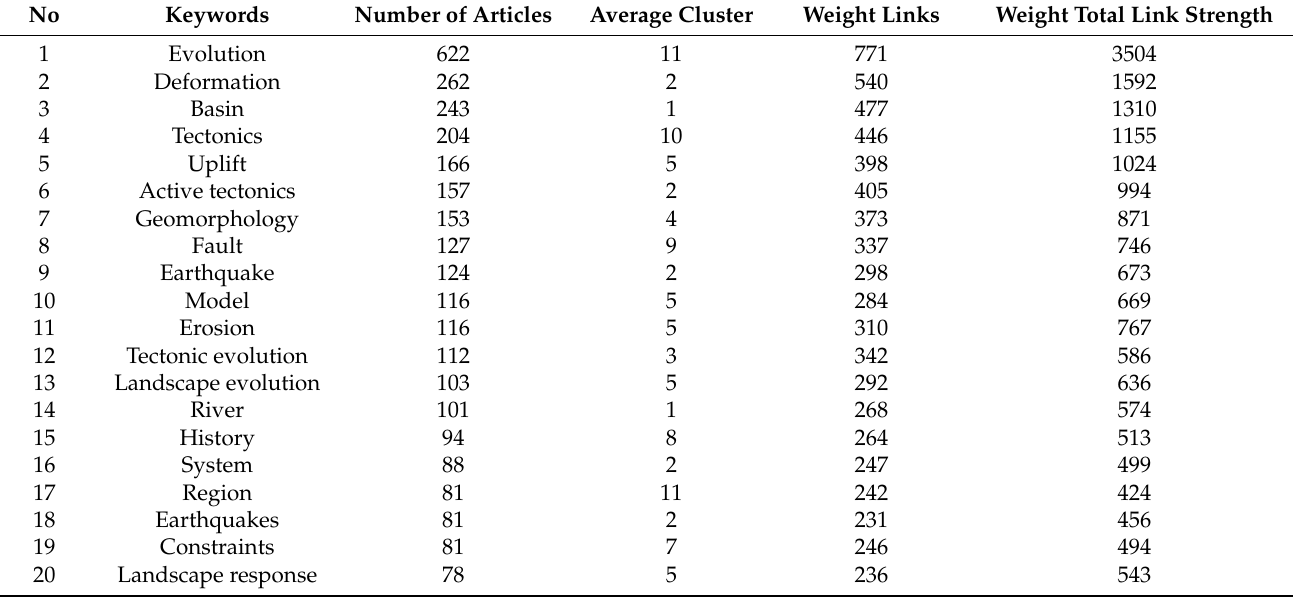
Table 5. Top 20 keywords on tectonic geomorphology research in